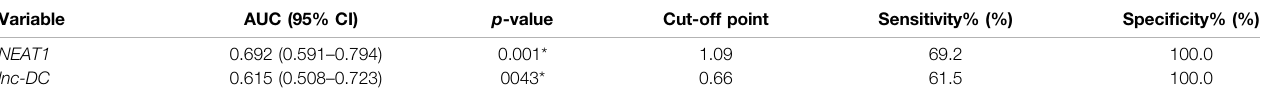
TABLE 5 | ROC curve analysis to determine the diagnostic performance of NEAT1 and lnc-DC.